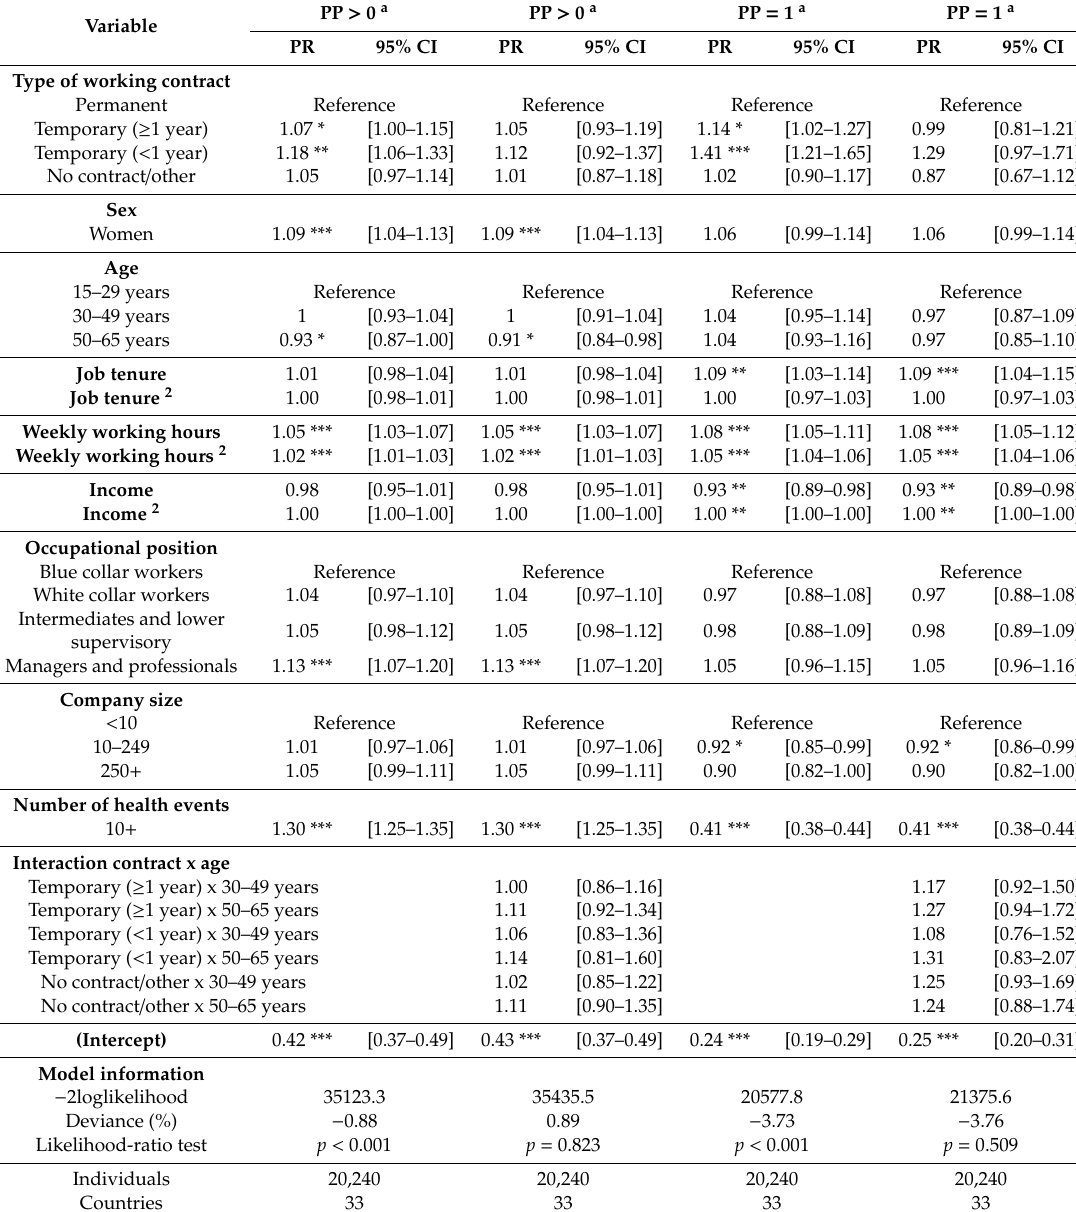
Table A3. Multilevel Poisson regression: Prevalence ratios (PR) for the likelihood of presenteeism propensity > 0 (presenteeism ever) and PP = 1 (every day worked while